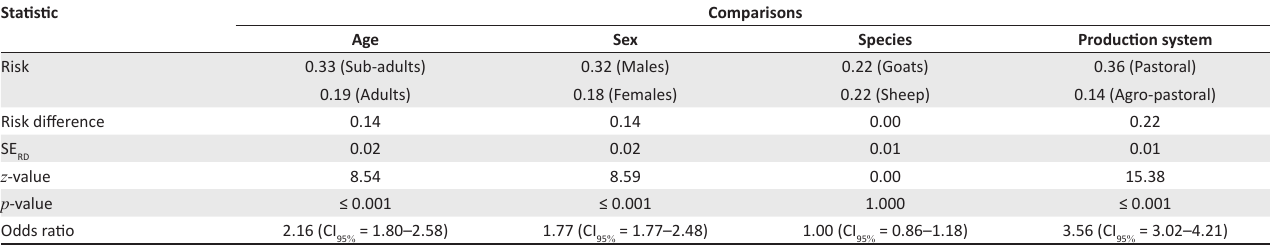
TABLE 2: Risk for peste des petits ruminants seroconversion according to animal age, sex, species and production system.